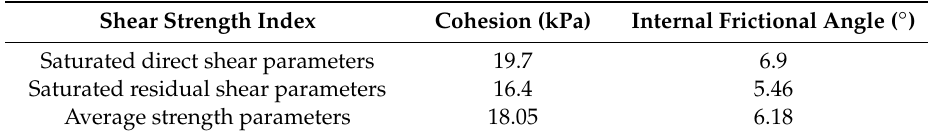
Table 3. Standard value of saturated direct shear and residual shear.